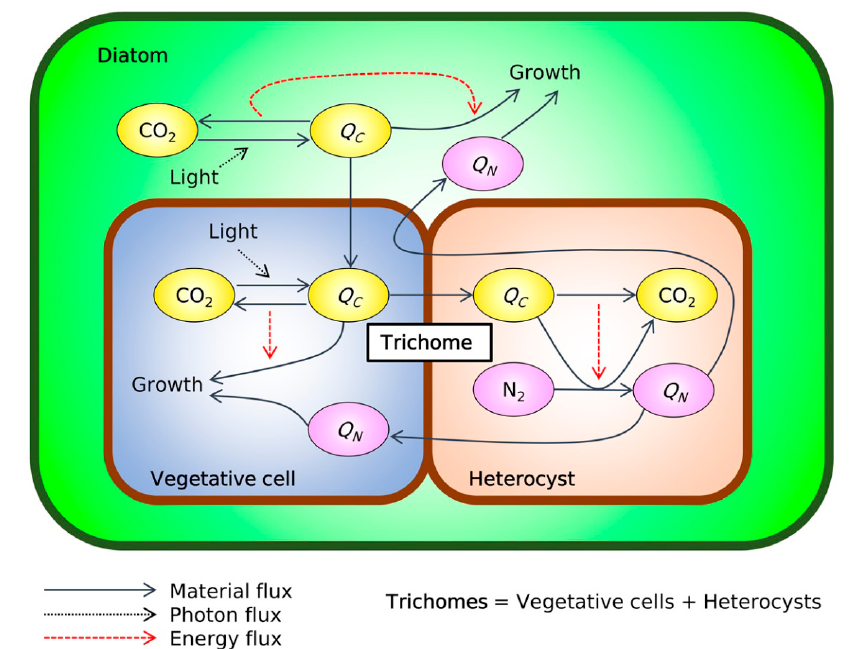
Figure 1. Schematic of the cell flux model of diatom–diazotroph association (CFM-DDA). Green frame: the silica frustule of the diatom ( Hemiaulus ). Brown frame: cell membrane layers of trichomes ( Richelia ). Green space: intracellular space of the diatoms. Blue space: intracellular space of vegetative cells. Orange space: intracellular space of heterocysts. Yellow ovals: C-based molecules. Pink ovals: N-based molecules. Q C and Q N indicate cellular quotas of C and N, respectively. A schematic with detailed notation is shown in Figure